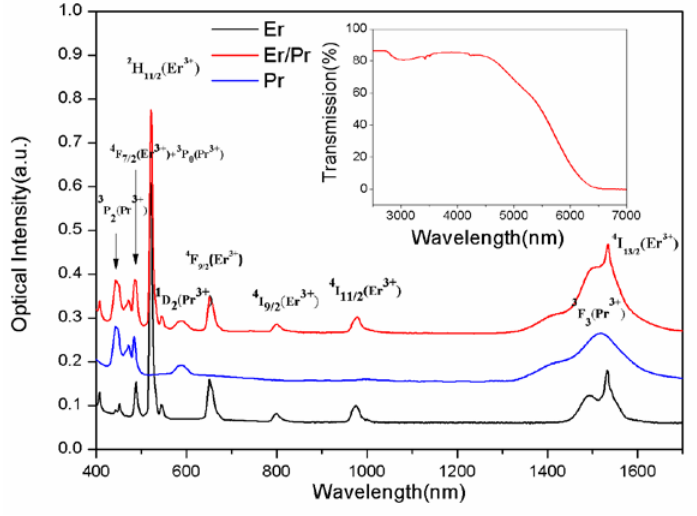
Figure 1. Absorption spectra of Er 3+ , Pr 3+ and Er 3+ /Pr 3+ codoped